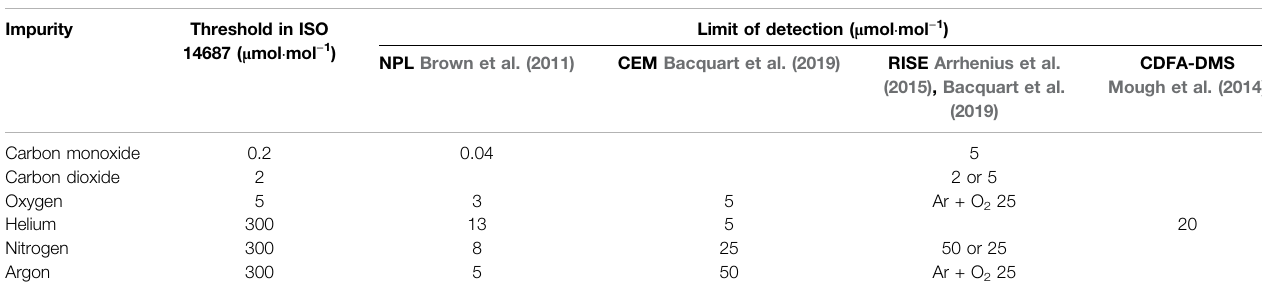
TABLE 4 | Detection limit per impurity with GC-TCD for NPL, CEM, CDFA-DMS and RISE.